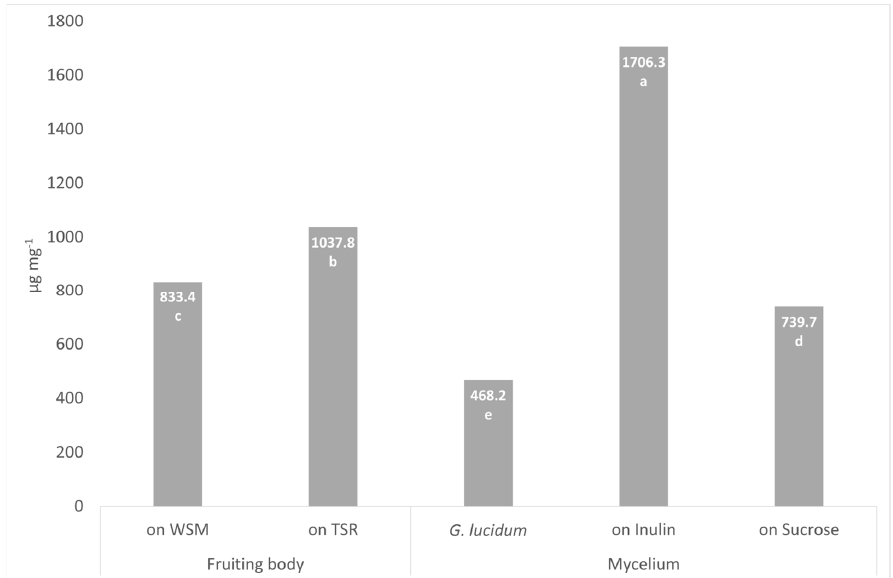
Figure 2. Heteroglycan content in fruiting bodies grown on wheat straw molasses (WSM) and cardunculus stems and cardunculus roots (TSR), and mycelium of P. eryngii and G. lucidum. The data represent the mean values of three experiments with three technical replicates. Different letters above the bars indicate significantly different according to Tukey’s test at p ≤ 0.05.